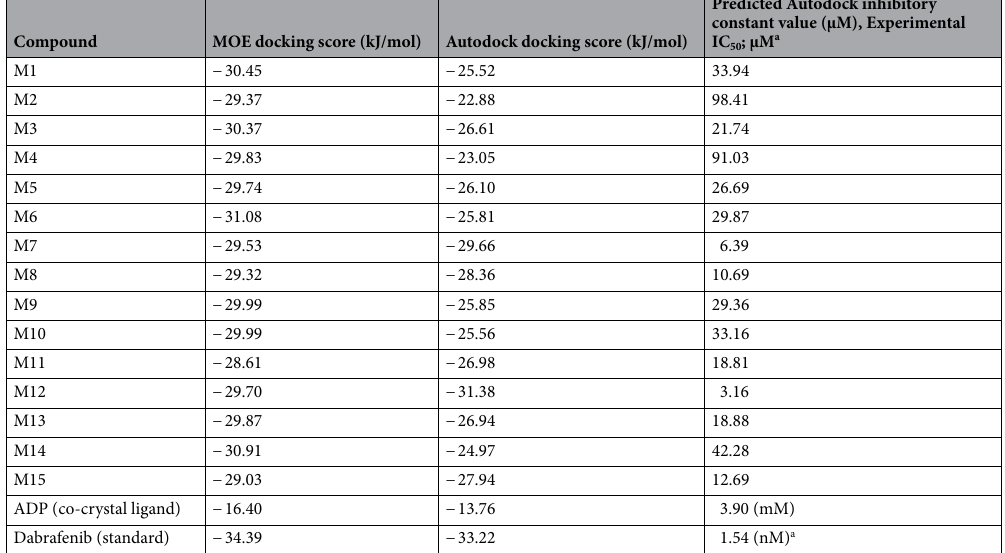
Table 3. Docking scores of phenylcarbamoylpiperidine-1,2,4-triazole amide derivatives.